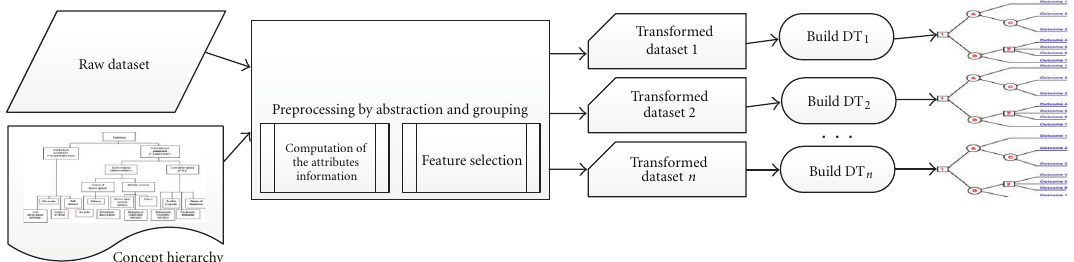
Figure 4: Framework of the Multilevel h-data generation